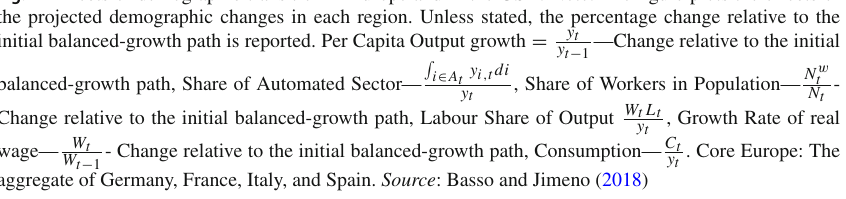
—Change relative to the initial (cid:15) t − 1 N w t i ∈ At y i , t di y t , Share of Workers in Population— N t - , Growth Rate of real t . Core Europe: The t